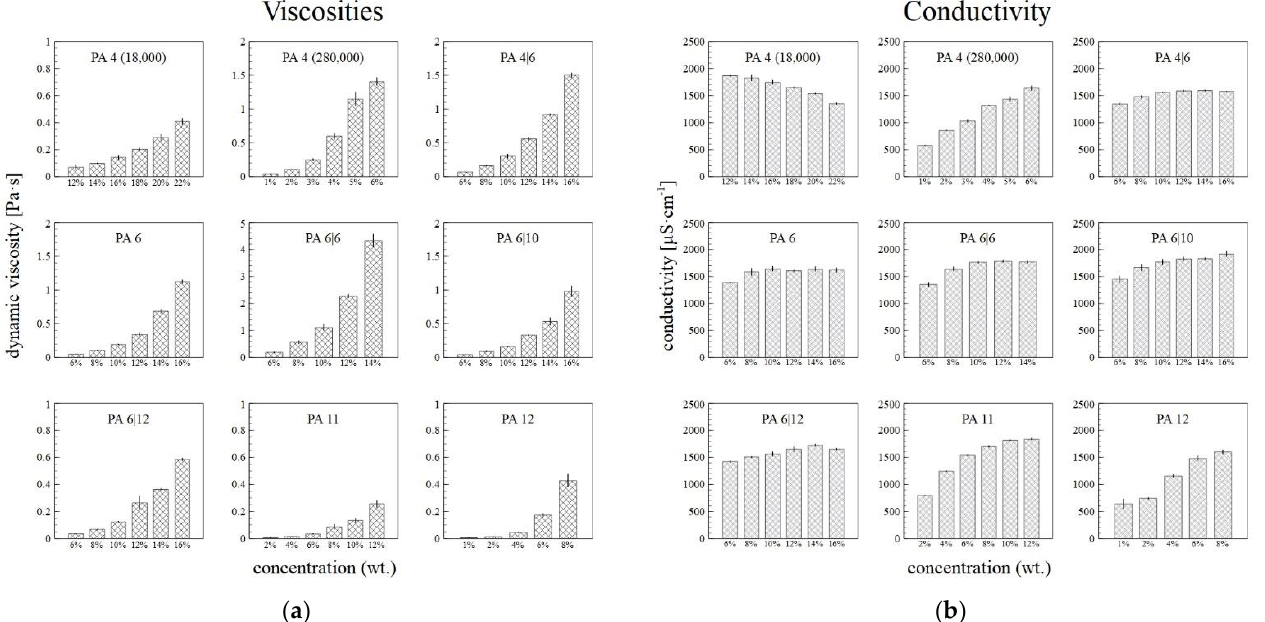
Figure 5. The dependence of the viscosity at shear rate of 500 s −1 ( a ) and conductivity ( b ) of the PA solutions on their concentrations, with the corresponding standard deviations.